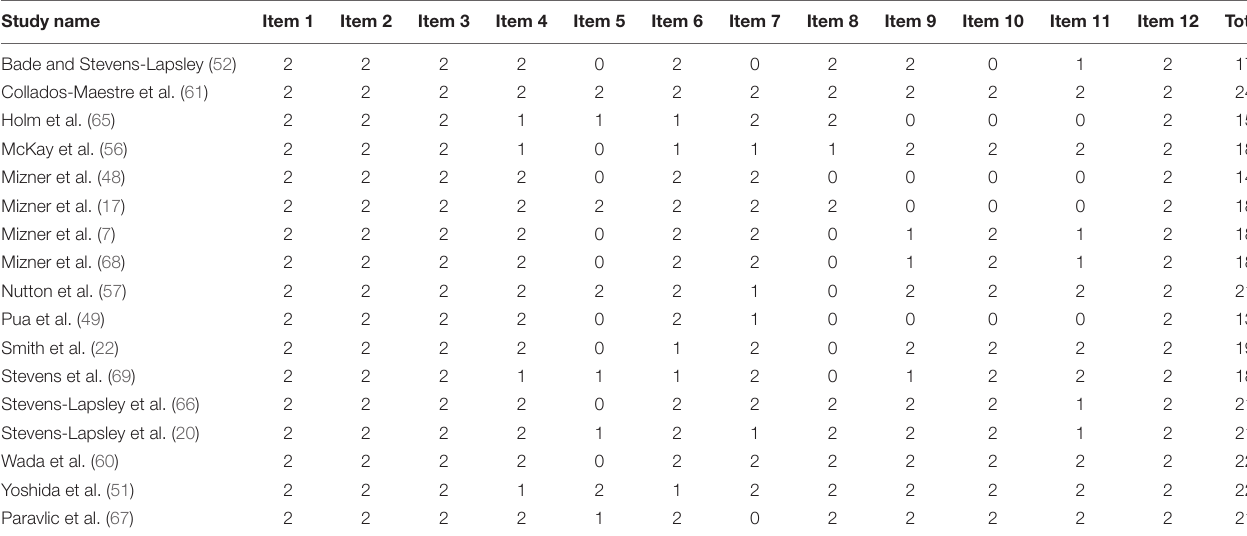
FIGURE 2 | Funnel plot of the standard differences in means vs. standard errors for all included effect sizes. TABLE 1 | Quality assessment of the included studies ( n =